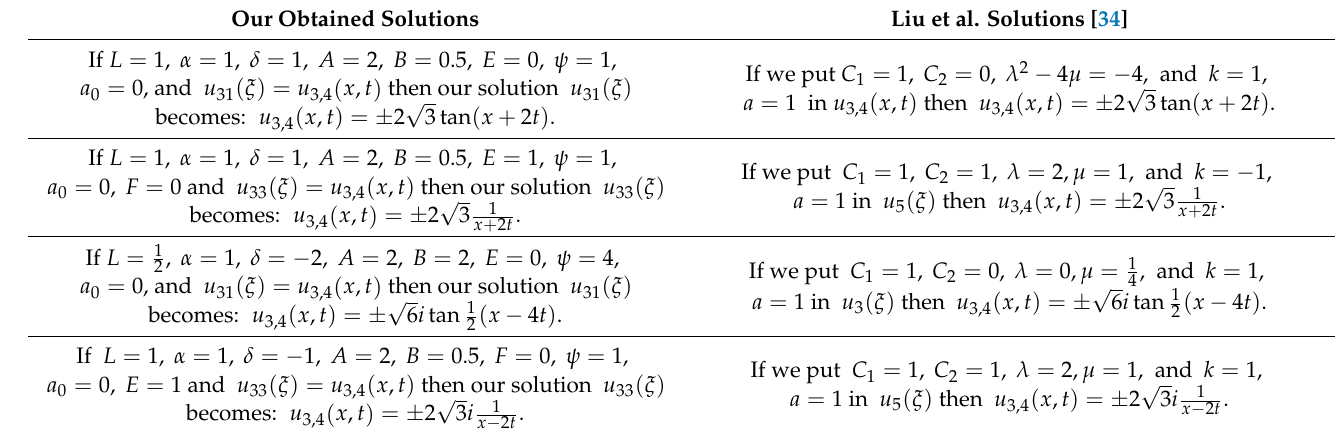
Table 1. Comparison between our obtained solutions and the Liu et al. solutions [34].